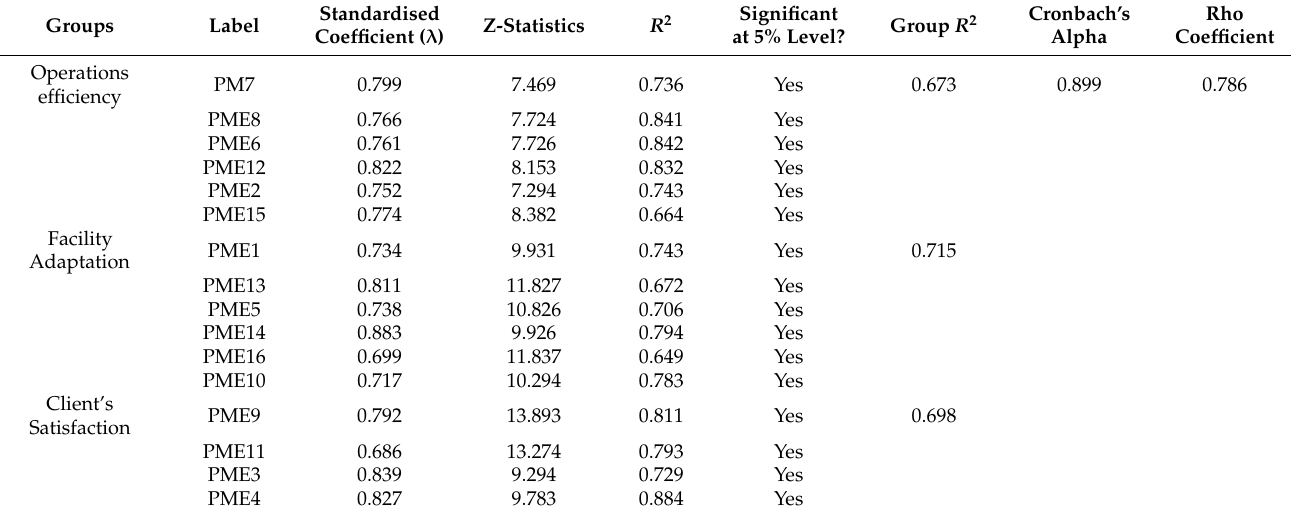
Table 5. Factor loading, z-statistics, and internal consistency of the